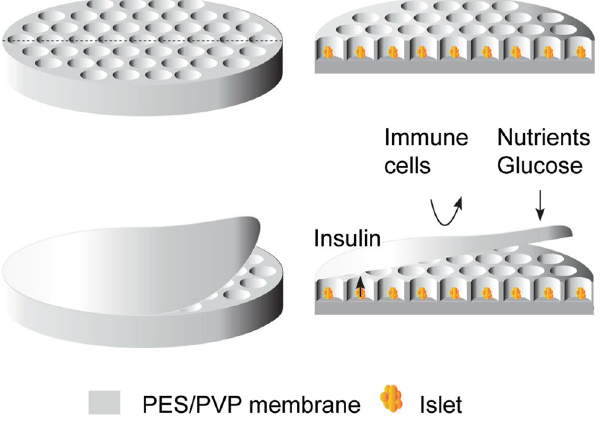
Figure 1. A schematic overview of the PES/PVP flat membrane encapsulation